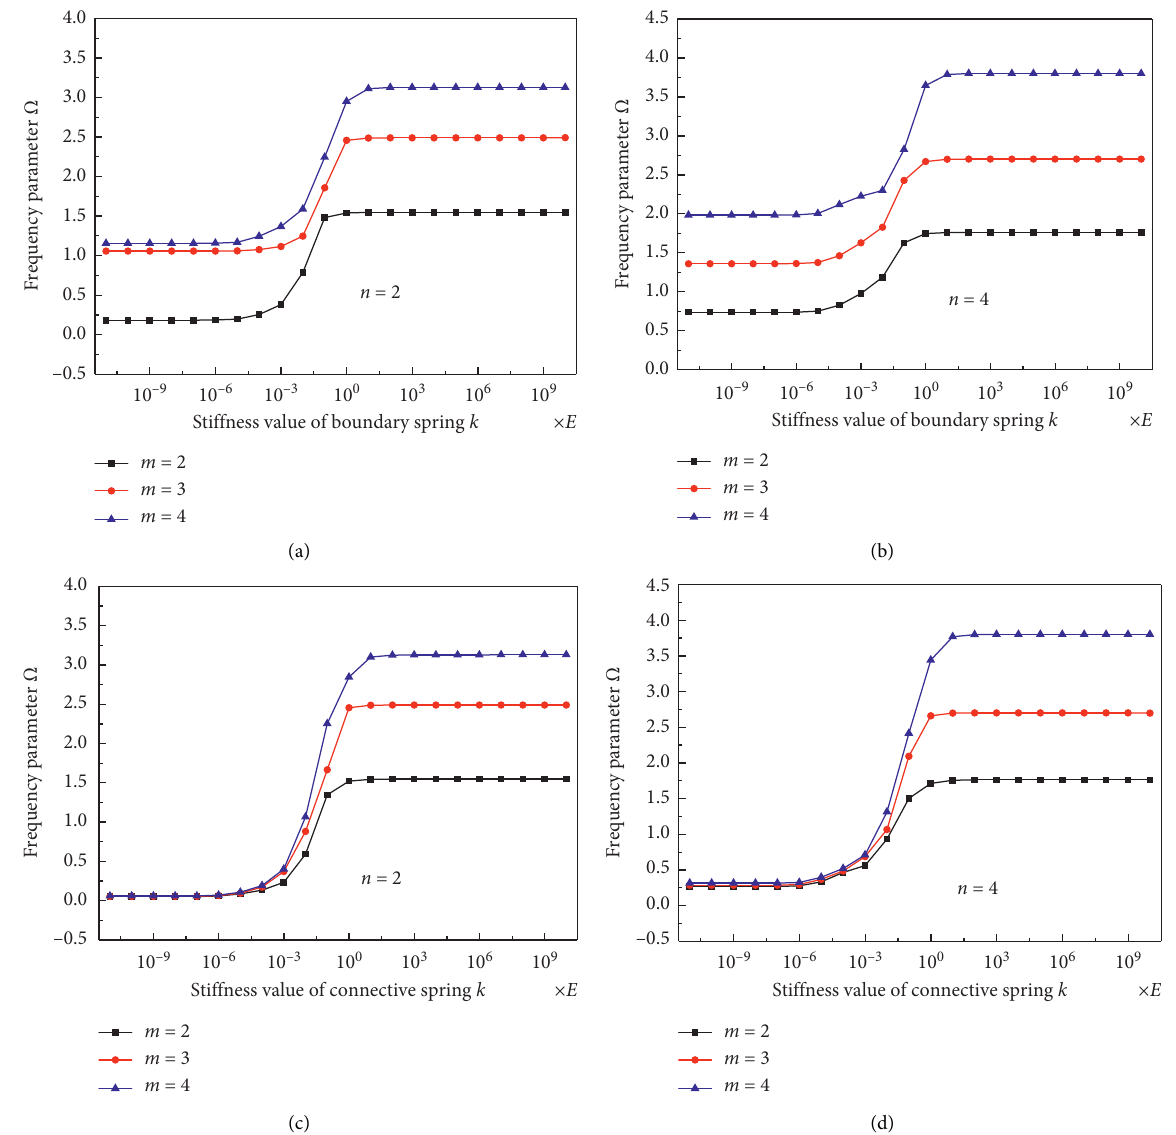
Figure 2: Frequency parameters Ω of the annular spherical shell with different boundary